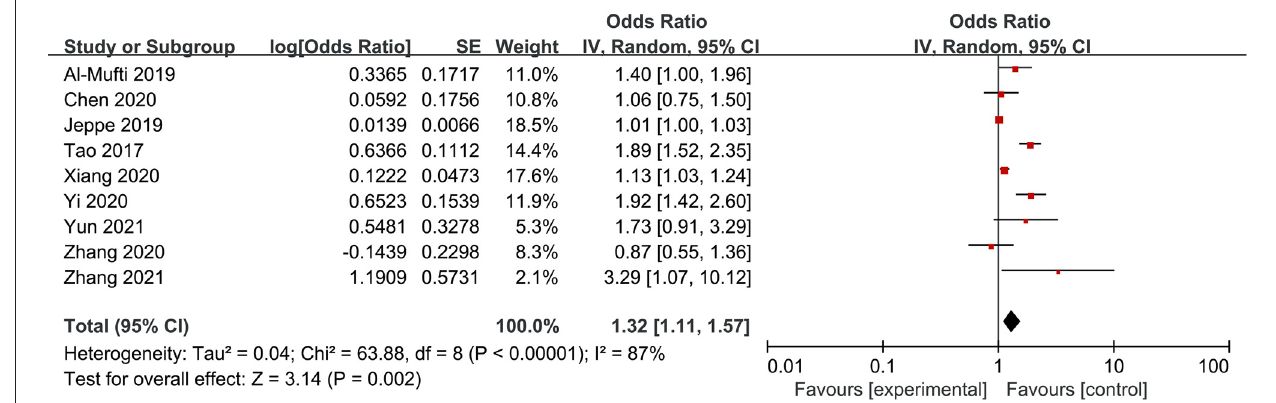
FIGURE 2 | Meta-analysis of the association between NLR and poor outcome.